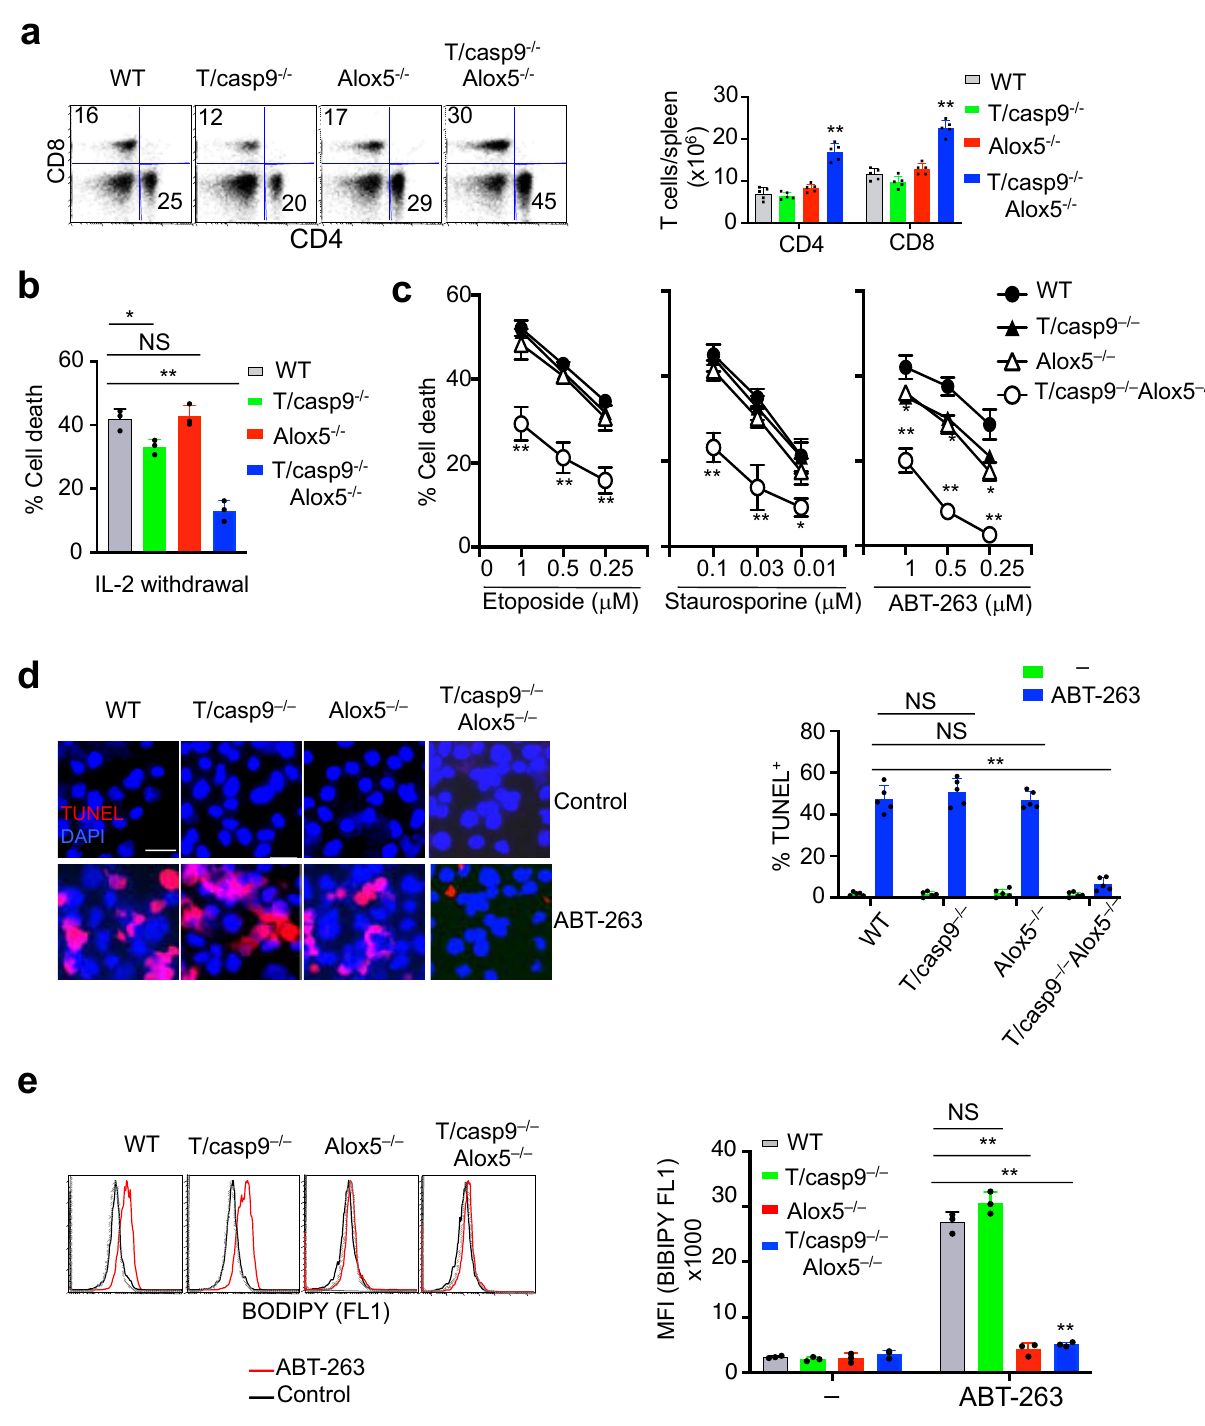
Figure 8. Inhibition of cell death by double knockouts of caspase-9 and Alox5 in T cells. ( a ) Flow cytometry analyses of CD4 + and CD8 + T cells in the spleen of 2-month-old T/caspase-9 − / − Alox5 − / − , T/caspase-9 − / − , Alox5 − / − or wild-type (WT) mice (upper panel). ( b , c ) T cells activated with ConA and IL-2 were cultured in ( b ) the absence of IL-2, or ( c ) treated with indicated apoptosis stimuli for 24 h. Percentages of cell death are presented as mean ± SD. Comparison to wild-type control: * p < 0.05, ** p < 0.01. ( d , e ) T cells cultured with ConA and IL-2 were treated with ABT-263 and used for ( d ) TUNEL or ( e ) BODIPY staining. Scale bar: 10 µ m. Comparison to wild-type control: NS, statistically not significant; ** p <